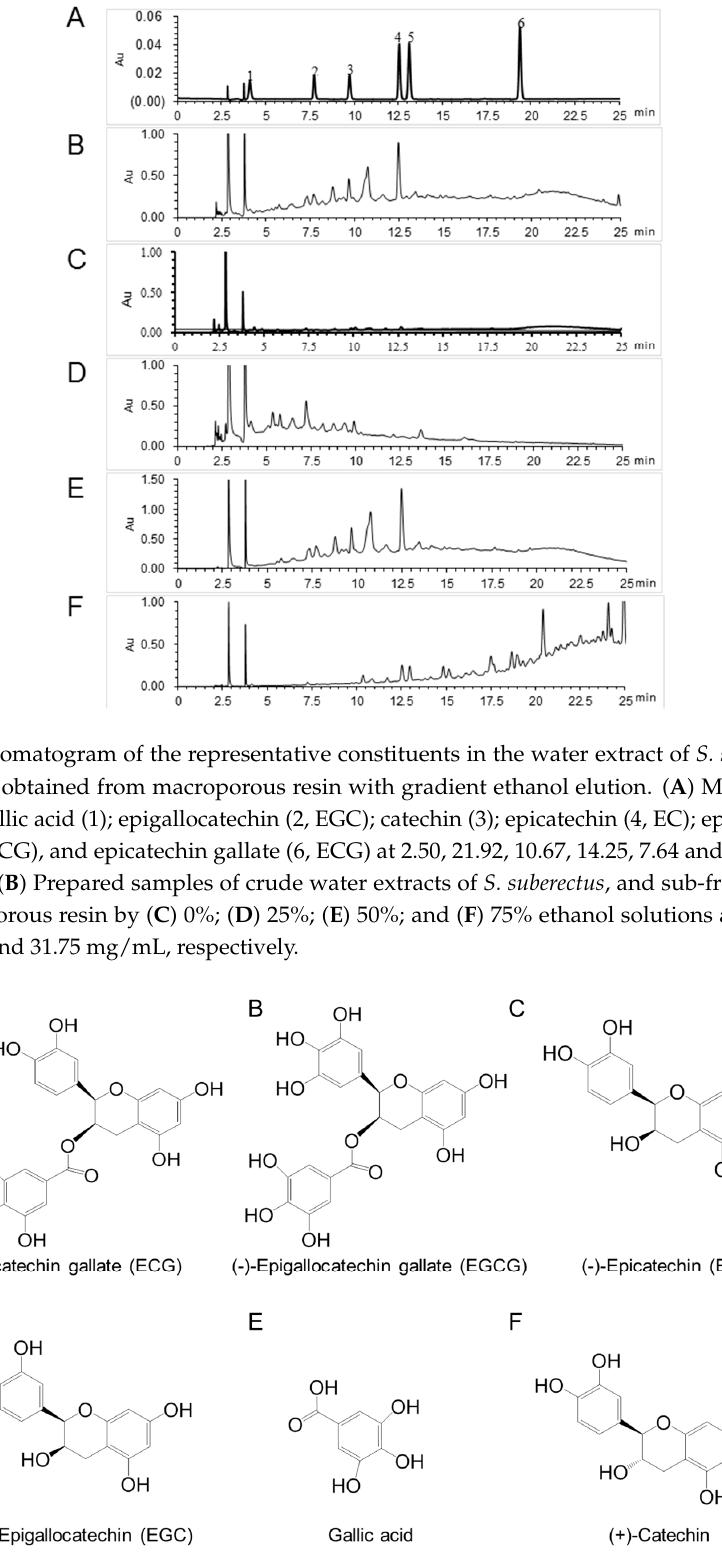
Figure 7. Chemical structures of ( A ) ECG; ( B ) EGCG; ( C ) EC; ( D ) EGC; ( E ) gallic acid; ( F ) (+)-catechin.